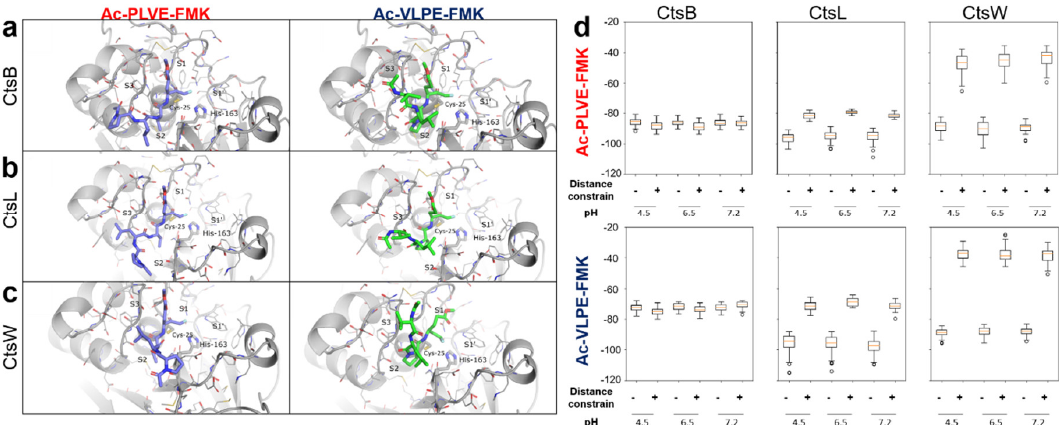
Figure 2. Binding poses of designed inhibitors to cysteine cathepsins (Cts). Docking of the peptides in ( a ) CtsB,( b ) CtsL, ( c ) CtsW (pH 4.5). Hydrogen atoms are omitted for better depiction. Catalytic Cysteine and Histidine are shown in thick sticks. Inhibitors are shown in purple or green. S1-S3 and S1’ binding pockets are labeled. ( d ) Binding scores (PLANTS Chemplp energy units) for Ac-PLVE-FMK and Ac-VLPE-FMK docking results at different pH levels with and without distance constraints.